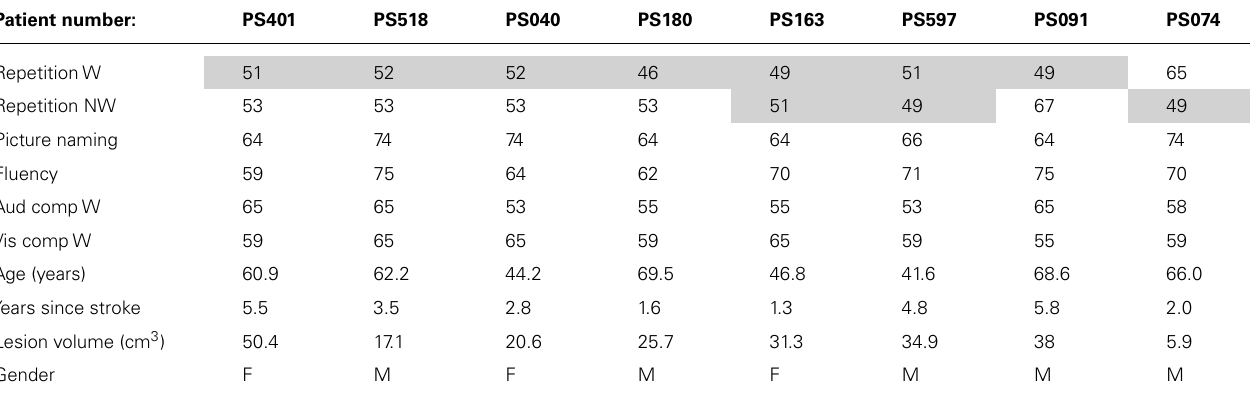
Table 1 | Patients with conduction